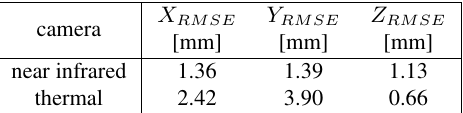
Table 5: RMSE of marker coordinates after 3D Helmert trans- formation with fixed scale on basis of near infrared and thermal image data. Table 6: RMSE of marker coordinates of the calibration field. target points were calculated on basis of measured image coordi- nates, determined camera pose and calibrated camera parameter from near infrared and thermal camera by using spatial intersec- tion. The RMSE of the coordinates are shown in Table 4. The result of the thermal camera is in an acceptable range with regard to the intended application and a ground sample distance (GSD) of 5.88mm related to an object distance of about 4.5m. The situ- ation is different to the RMSE of the object coordinates resulting from near infrared image data. An additional analysis of the re- sults, in detail a 3D Helmert transformation of the determined